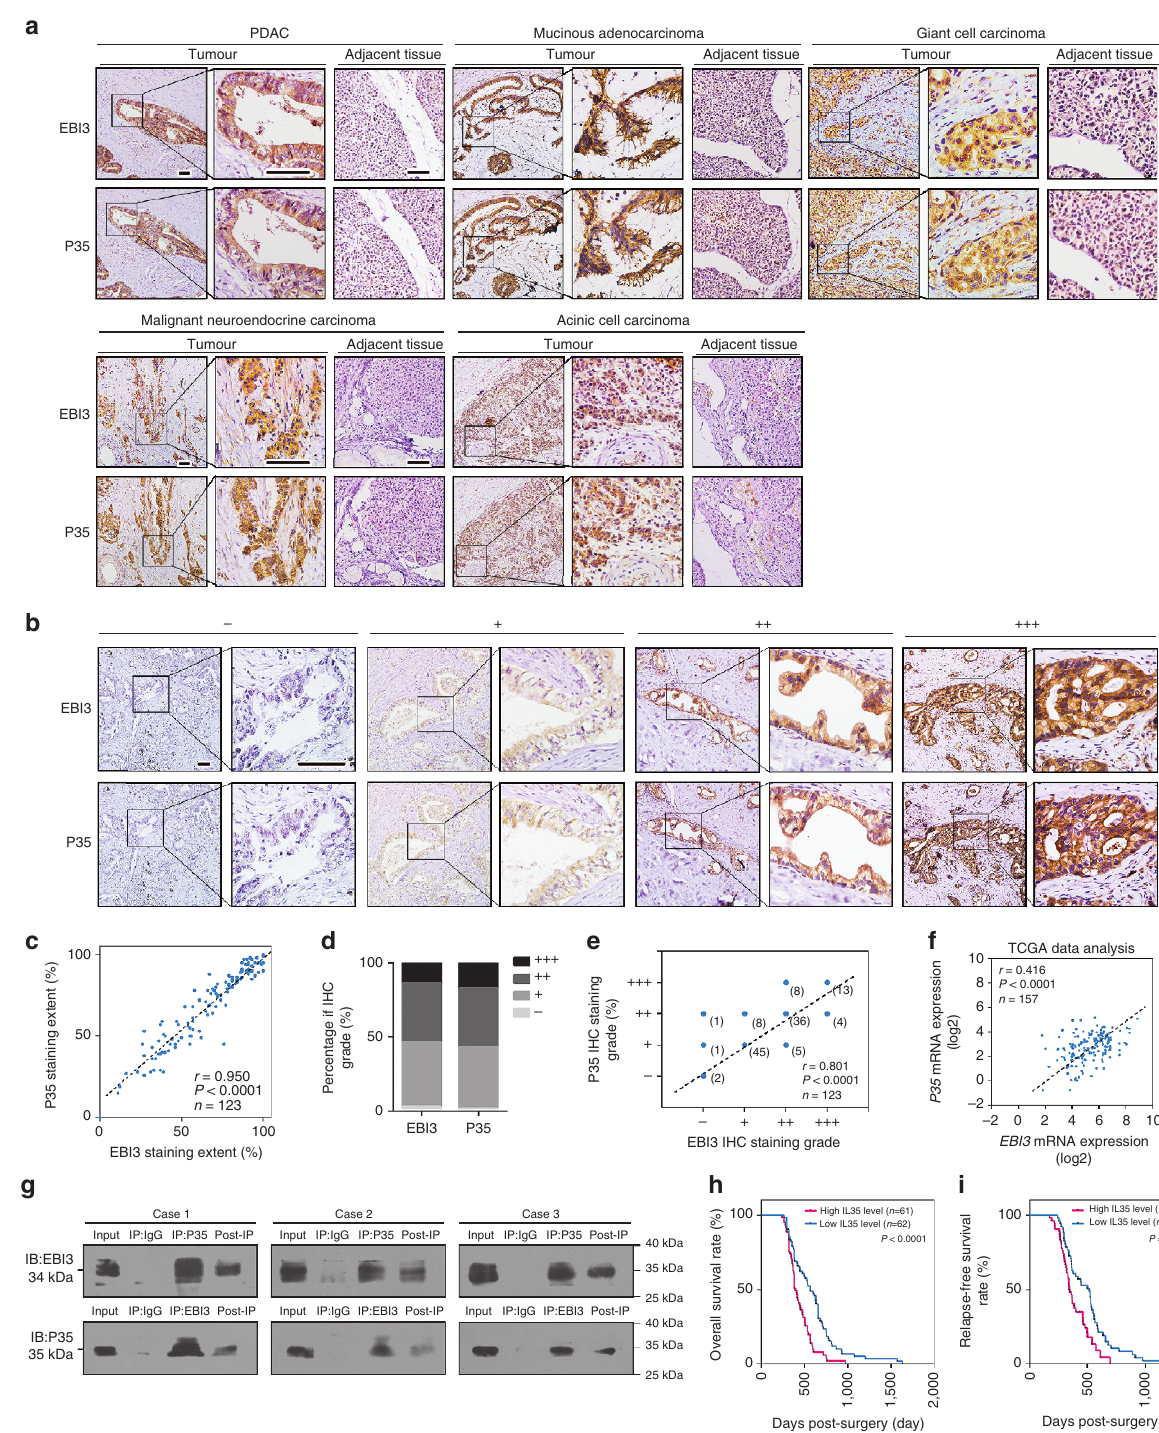
Figure 1 | Expression of IL-35 and clinical significance in pancreatic carcinomas. Consecutive sections of pancreatic carcinoma tissues were used to analyse the expression levels of the two subunits of the IL-35 ligand: EBI3 and P35. ( a ) IHC staining of EBI3 and P35 proteins in five representative histologic types of pancreatic carcinoma (PDAC, mucinous adenocarcinoma, giant cell carcinoma, malignant neuroendocrine carcinoma and mucous cell carcinoma) and the adjacent normal pancreatic tissues. ( b ) Representative images are shown for absent, low, median and high expression of EBI3 and P35 in IHC staining in PDAC tissues. ( c – e ) The distribution of IHC results ( c ), staining extent correlation ( d , Pearson’s correlation analysis) and IHC result correlation ( e , Spearman’s correlation analysis) analysis of EBI3 and P35 in 123 PDAC patients. ( f ) Spearman’s correlation analysis of the mRNA expression profiles of EBI3 and P35 in 157 PDAC patients from TCGA. ( g ) Co-immunoprecipitation and western blot analysis of EBI3 and P35 proteins from tumour tissue lysates of three PDAC patients, the remaining supernatant post immunoprecipitation (Post-IP) was also detected. ( h , i ) Kaplan–Meier analysis of OS ( h ) and RFS ( i ) of 123 PDAC patients ( P ¼ 0.0010 and 0.0072, respectively, by log-rank test) according to different IL-35 levels. The test of significance is two-sided. Figure panel pairs in a and b represent images taken with different zooming options; scale bars, 100 m m.